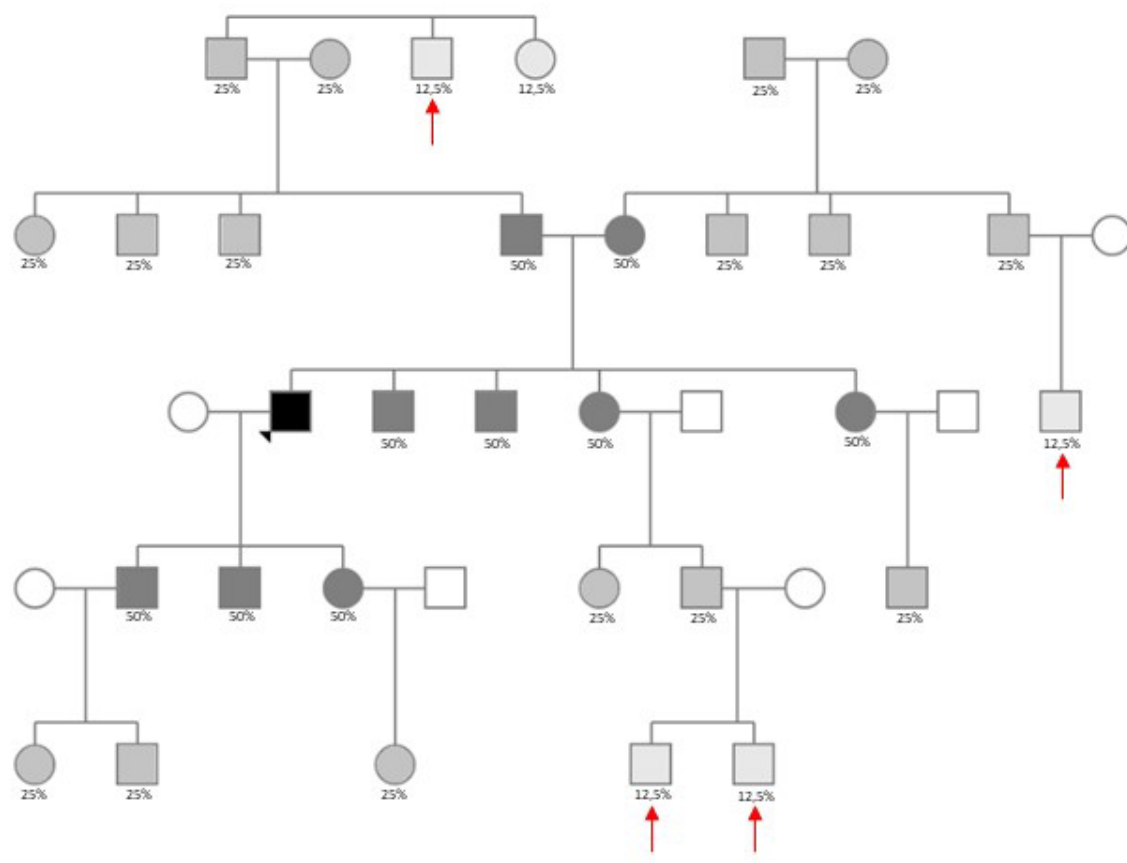
Figure 3 – Illustration of a family tree used to solve a crime using Investigative Genetic Genealogy. In this example, after uploading large-scale SNP genotype data from the sample retrieved in the crime scene into GEDmatch, there was a ~12.5% match with a given individual (a DTC consumer). The exploration of different genealogy databases resulted in at least this family tree that included the DTC consumer (represented with a black square). The grey-scale shows individual who share DNA with the DTC consumer, and the numbers bellow each symbol shows the expected average of shared DNA. Red arrows show the four main suspects arising from this genealogy. Additional information from the perpetrator and from these four main suspects, such as gender, age, location (crime scene vs. residence), and predicted ancestry and phenotypes, for example, should be used to narrow down the number of suspects and track the actual